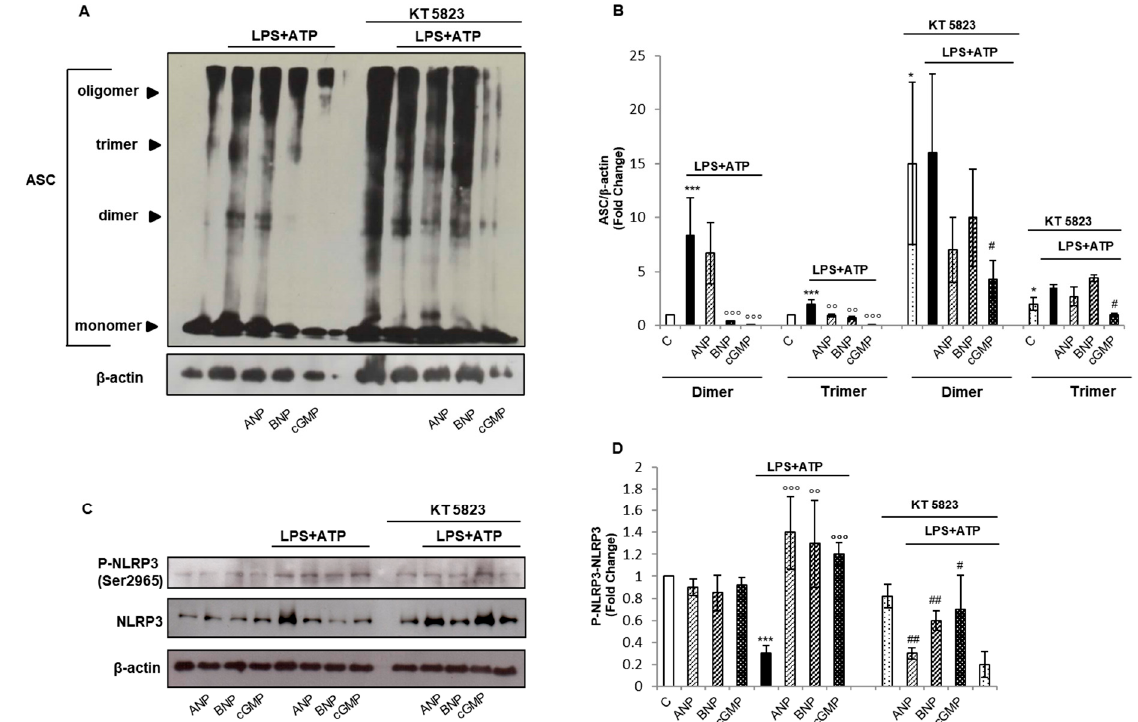
Figure 4. cGMP/PKG-I axis induces NLRP3 phosphorylation. THP-1 cells were pre-treated for 10 min with ANP (10 − 8 M) or BNP (10 − 8 M) or cGMP (100 µ M 8-Br-cGMP) in the absence or presence of LPS (10 µ g/mL for 20 min) + ATP (5 mM for 40 min). When KT-5823 (1 µ M) was used, it was added 1 h before ANP, BNP, or 8-Br-cGMP treatment. ( A ) ASC oligomerization assessed by crosslinking assay followed by Western blot analysis. ( C ) Cell lysates were immunoblotted for p-NLRP3 (Ser295) or total NLRP3. The blots were stripped and re-probed with mouse anti- β -actin, to confirm equal loading. Representative western blots images are shown. ( B , D ) Histograms represent densitometric quantification. Bars represent the ratio between active p-NLRP3 and NLRP3 or dimeric and trimeric ASC and β -actin band intensity. Untreated cells were used as control and assumed as 1. The histogram indicates mean ± SD of at least n = three independent experiments, each one tested in triplicate. * p < 0.05, *** p < 0.001 versus untreated cells; ◦◦ p < 0.01 and ◦◦◦ p < 0.001 versus LPS + ATP treated cells; # p < 0.05 and ## p < 0.01 versus KT-5823 + LPS + ATP treated cells.